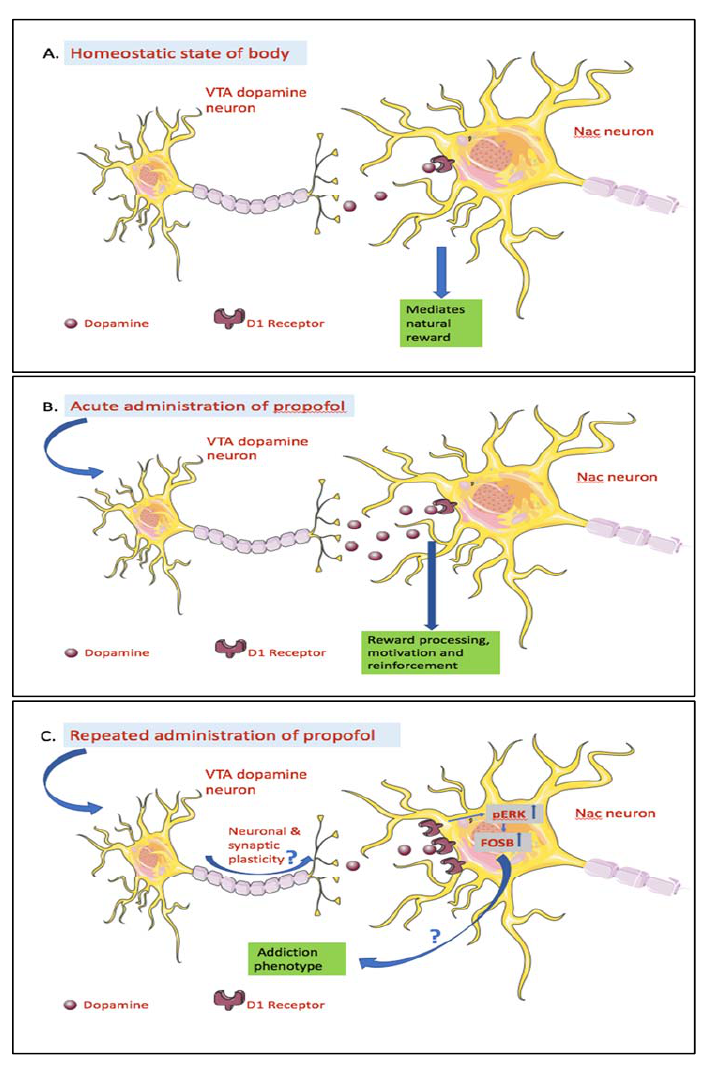
Figure 1. Effects of acute and repeated administration of propofol on the mesolimbic system.